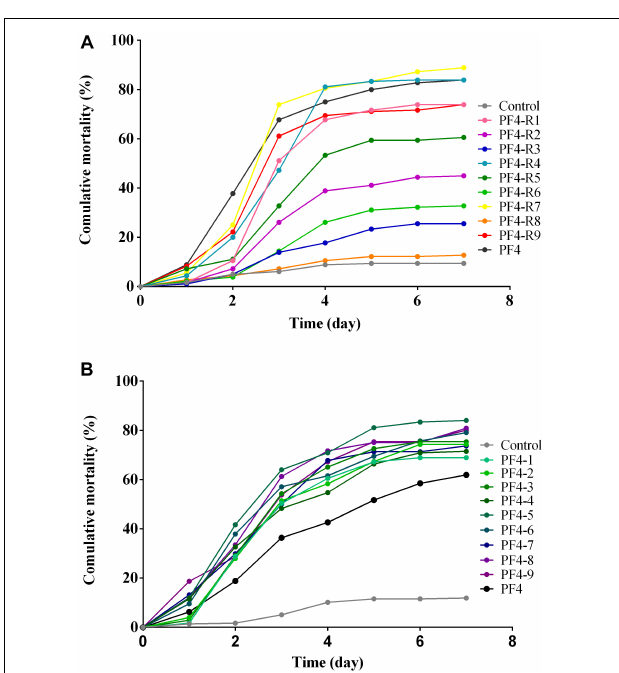
FIGURE 6 | Challenge in Gilt-Head Sea bream ( S. aurata ) larvae with V. anguillarum strains. (A) Strains resistant to the CHOED phage. (B) Clones of parental strains. Test carried out in 96-well plates using one ova/larva per well. Mortality of the larvae was monitored daily for 7 days. All strains inoculated to attain the same final concentration ( ∼ 5 × 10 6 CFU/mL). The control corresponds to larvae with the same volume of sterile seawater.